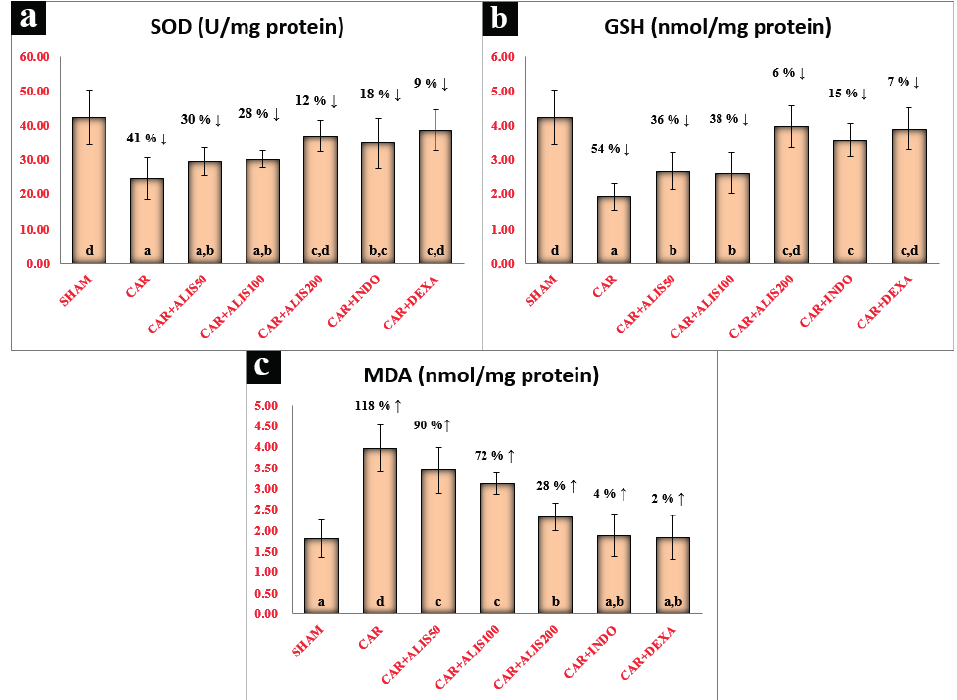
Figure 1 - Effects of Aliskiren treatments on SOD activity, GSH and MDA levels in rats’ lungs . SHAM: Sham-operated, ALIS: Aliskiren 50-100-200 mg/kg, CAR: Carrageenan, INDO: Indomethacine, DEXA: Dexamethasone. Means in the same column by the same letter are not significantly different to the test of Duncan (p<0.05). Results are means ±